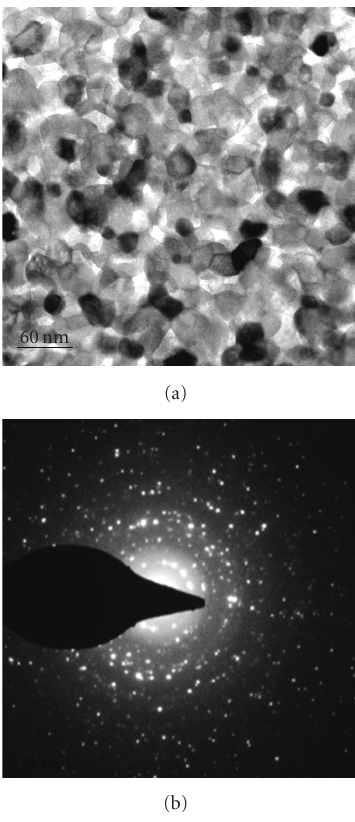
Figure 4: (a) A plan-view TEM micrograph and (b) Selected area di ff raction (SAD) pattern for CBTi144 film deposited by the soft chemical method at 700 ◦ C for 2